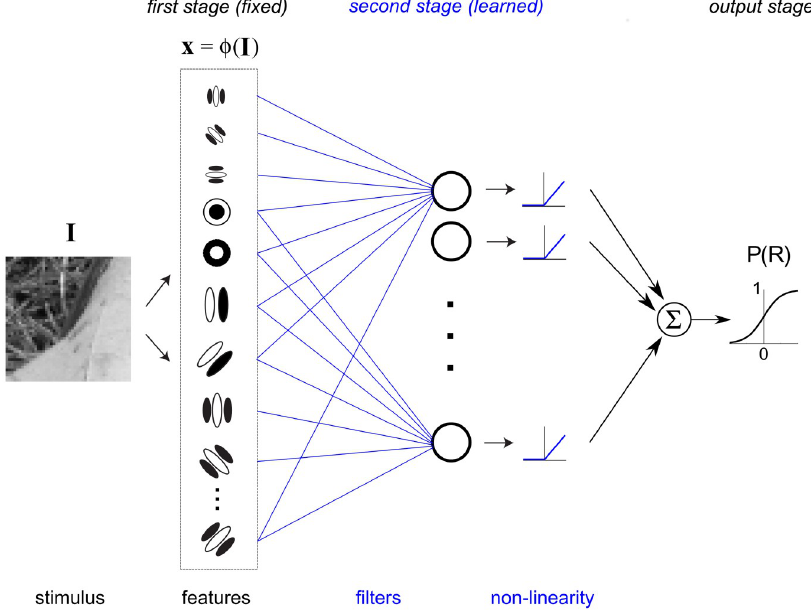
Fig 13. Hypothetical extension of our modeling framework with additional second-stage filters and a more complete implementation of the first-stage filters. Such a model could potentially be fit to human observer performance on boundary perception tasks involving complex stimuli such as natural occlusion